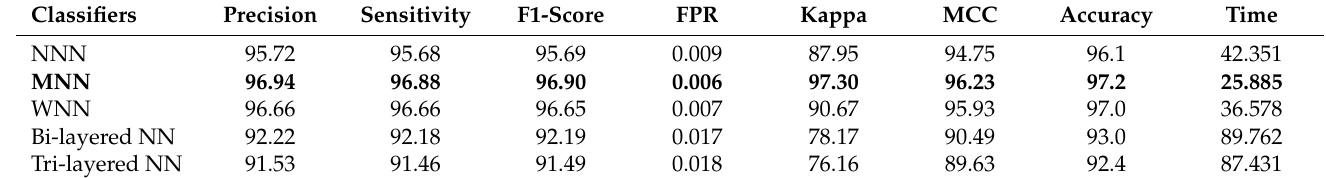
Table 9. Proposed fusion method results on COVID-19 Image dataset.